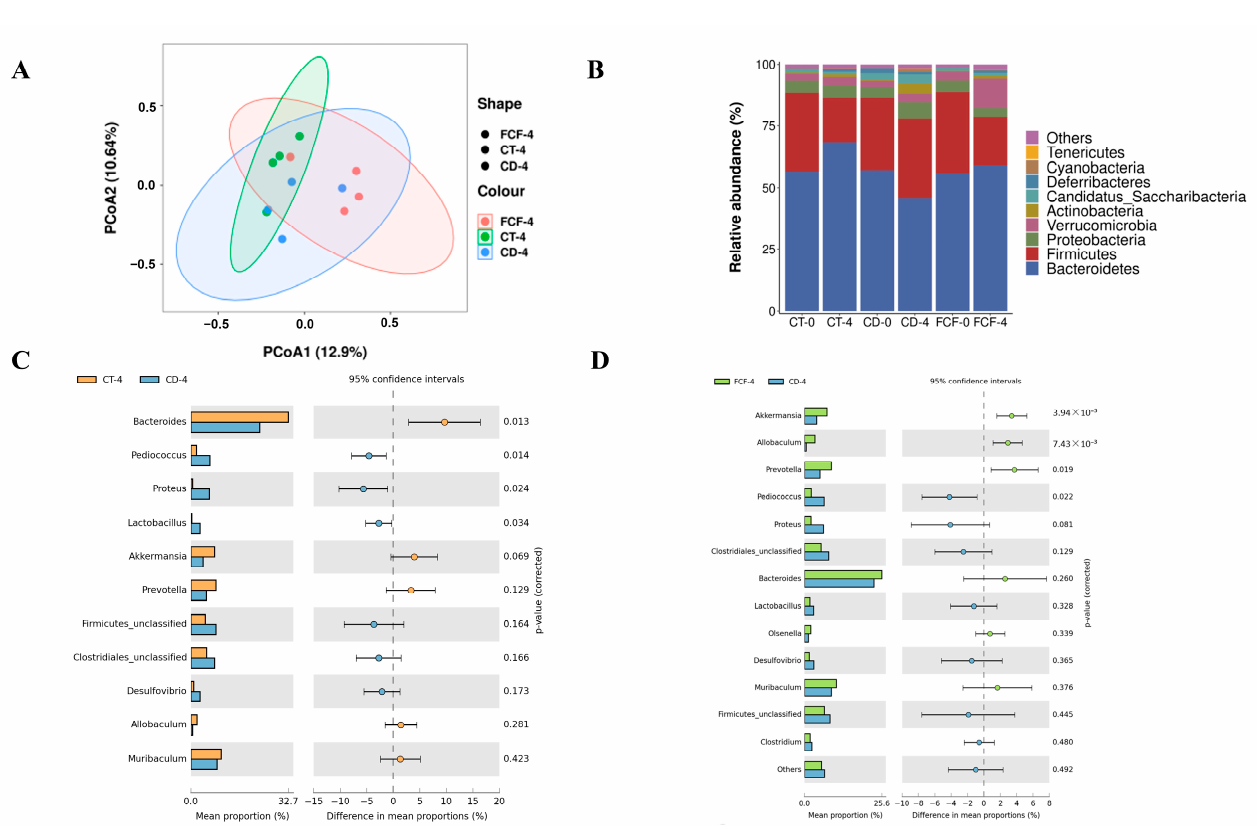
Figure 3. ( A ) Principal component analysis of fecal microbiota of the three groups. ( B ) The relative abundance of intestinal flora at the phylum in each group (Weeks 0 and 4). The comparison of relative abundance of the intestinal microbiota at genus in the 4th week between CD and CT group ( C ), CD and FCF group ( D ).